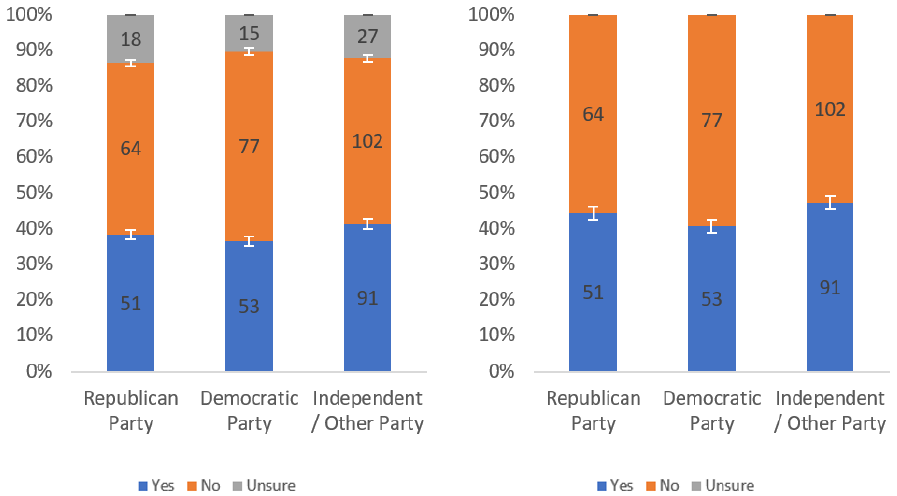
Figure 59. Responses regarding label annoyingness by party affiliation including ( left ) and excluding ( right ) unsure responses.